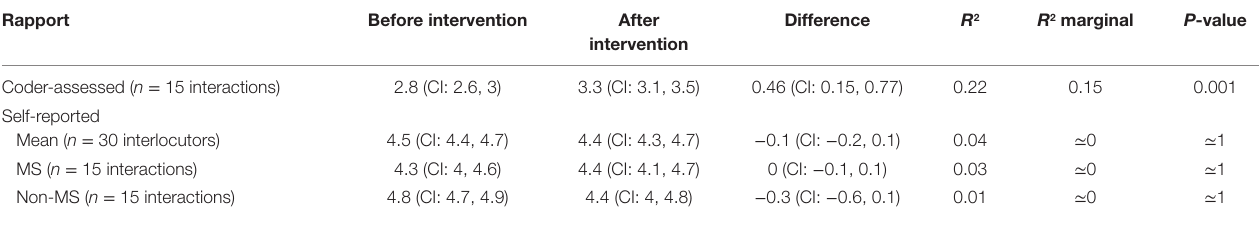
TaBle 2 | impact of intervention on rapport.